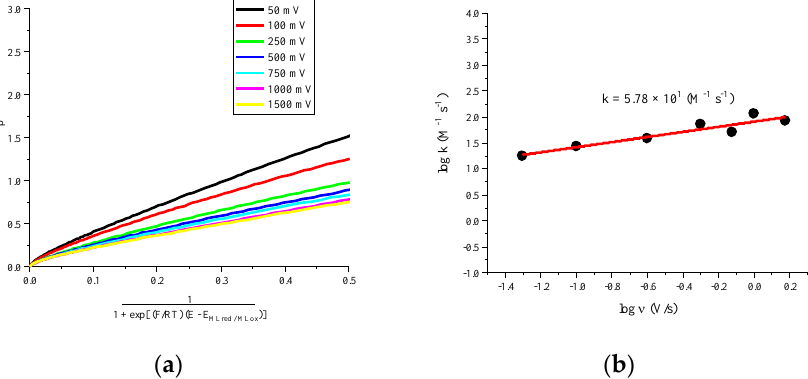
Figure 9. ( a ) FOWA of a 1 mM [Co II (terpy) 3 ](BF 4 ) 2 complex in MeCN with 0.1 M of TBAPF 6 as supporting electrolyte. ( b ) Logarithmic rate constant obtained from FOWA.